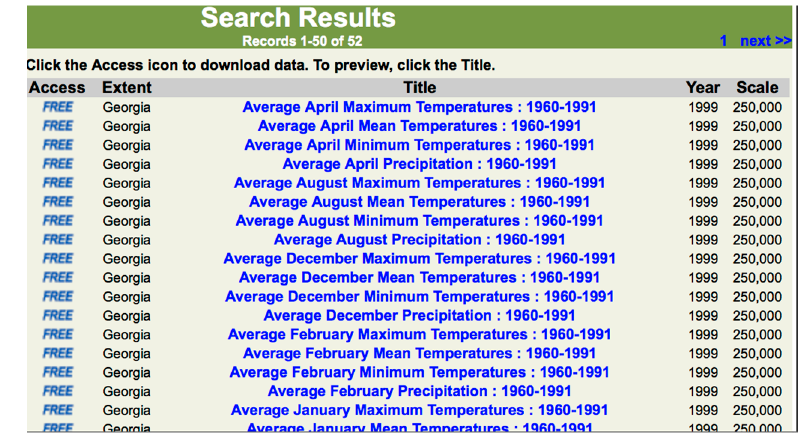
Figure 4. Monthly Temperature and Precipitation Data Files. Source: Georgia Spatial Data Monthly Temperature and Precipitation Data Files. Source: Georgia Spatial Infrastructure [26].